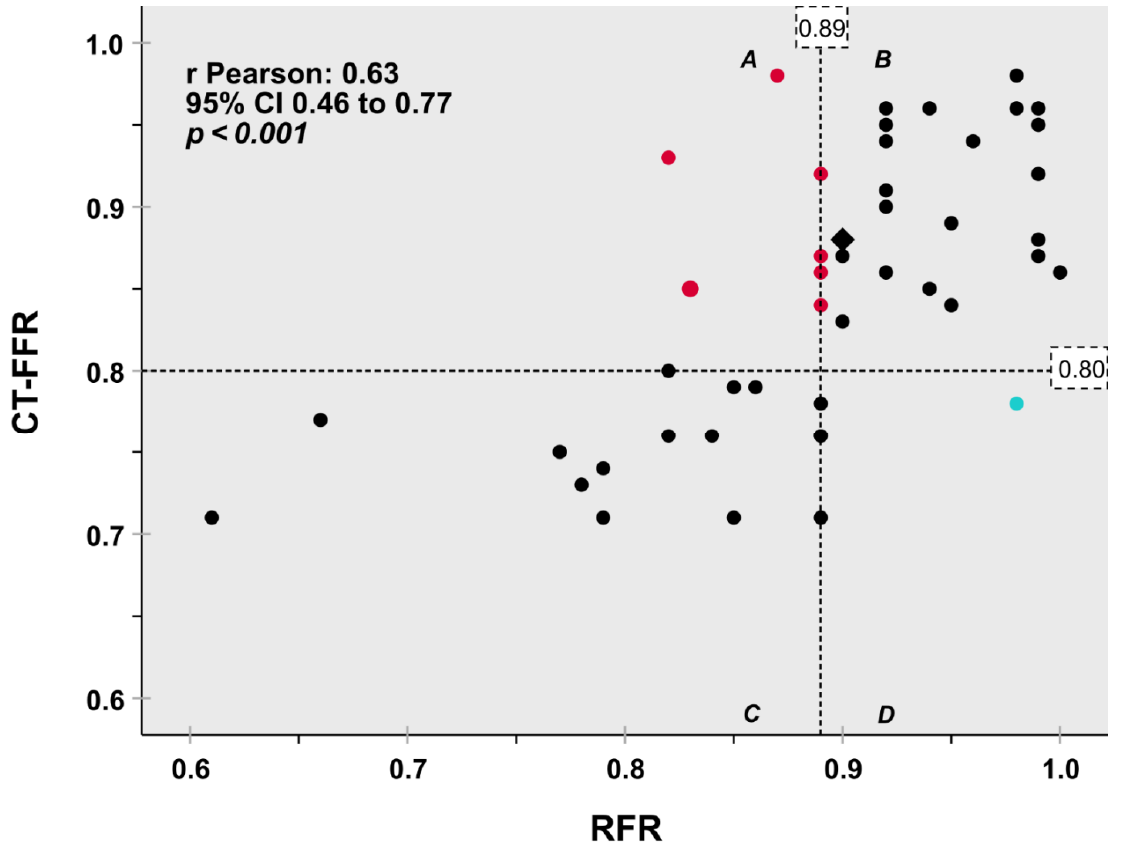
Figure 1. Scatter plot diagram for classification agreement of the hemodynamic relevance of coronary artery stenosis on a per lesion basis depicts good agreement between CT-FFR with invasive RFR as the reference standard. Dashed lines indicate the 0.80 CT-FFR and 0.89 RFR cut-off values. 82.6% concordant classification between CT-FFR and RFR (quadrants B + C, black symbols) was observed. One lesion [2.2%] was false positive classified by CT-FFR (turquoise symbol, quadrant D). Seven lesions [15.2%] were false negative (red symbols, quadrant A). Two assessments yielded identical values (Rhombus). CT-FFR fractional flow reserve based on computed tomography angiography, RFR Resting full cycle ratio.